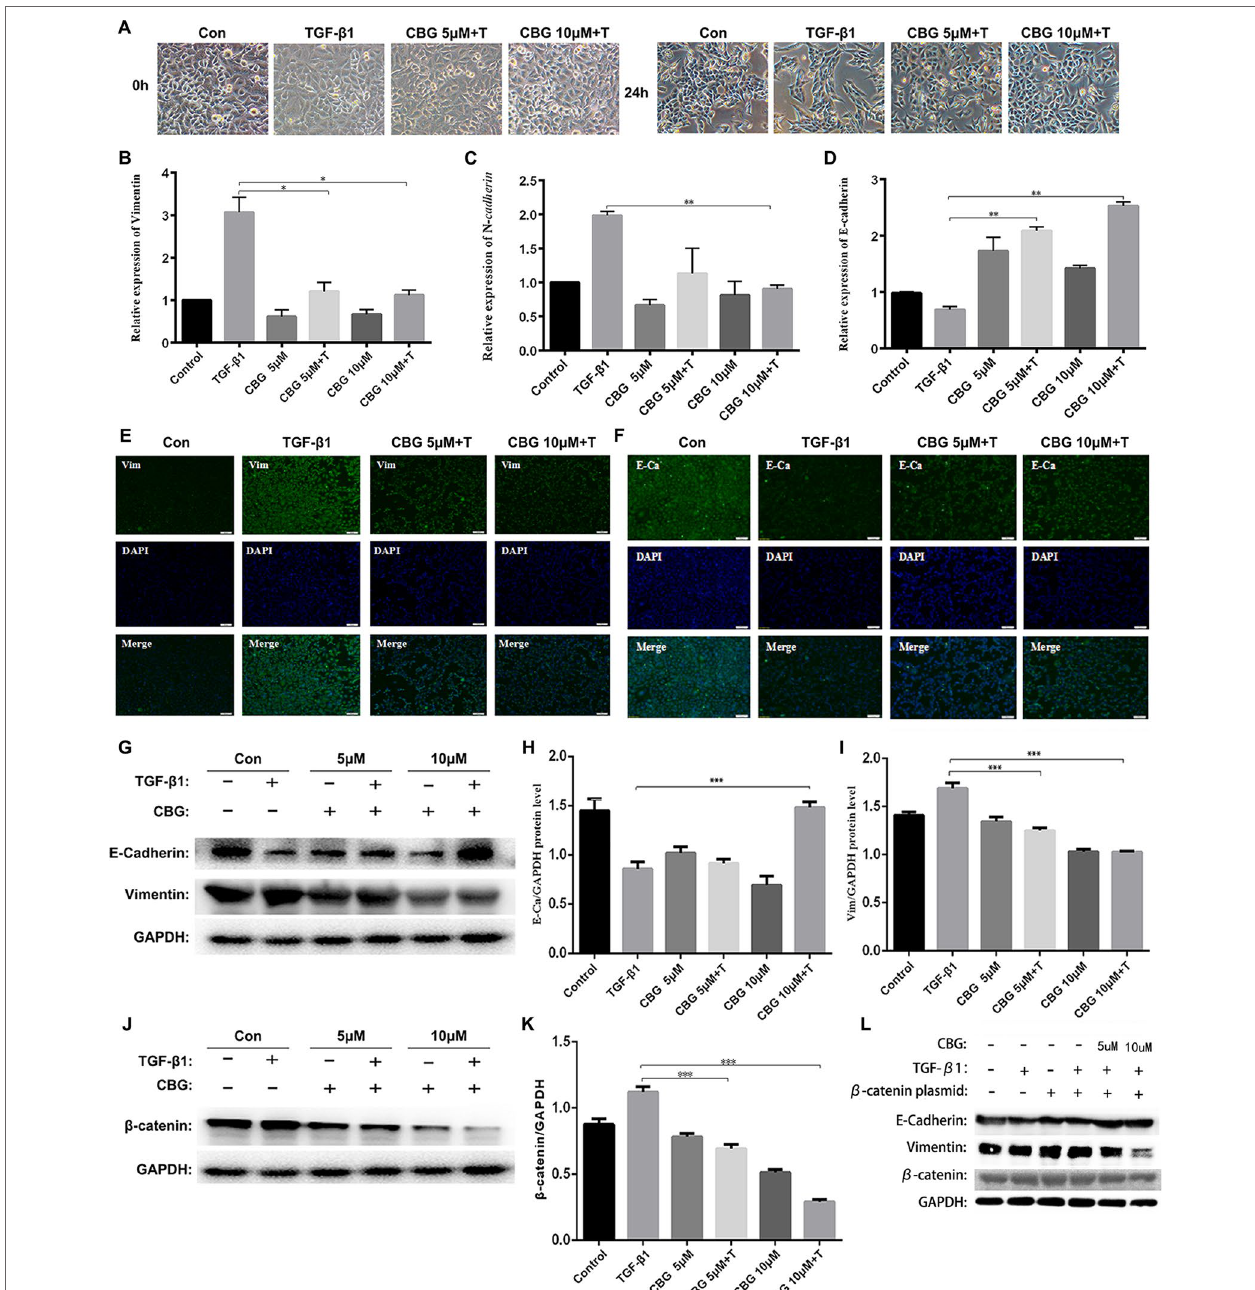
FIGURE 4 | Cinobufagin suppresses TGF- β 1-induced EMT in alveolar epithelial cells. A549 cells were treated with TGF- β 1 and different concentrations of cinobufagin (5 and 10 µM) for 24 h. Cells stimulated with DMSO served as controls (n = 3 per group). (A) Morphological changes of A549 cells. (B-D) mRNA levels of EMT makers, including Vimentin, N-cadherin, and E-cadherin. (E–F) Immunofluorescence analysis of Vimentin and E-cadherin in A549 cells. (G–I) Quantitative densitometry of different samples by western blot. Expression levels of E-cadherin and Vimentin were normalized to GAPDH. (J–K) Quantitative densitometry of different samples by western blot. Expression levels of β -catenin were normalized to GAPDH. (L) Detection of E-Ca, Vim and β -catenin protein expression after transfection of β -catenin plasmid by Western blot. *P < 0.05; **P < 0.01; ***P <